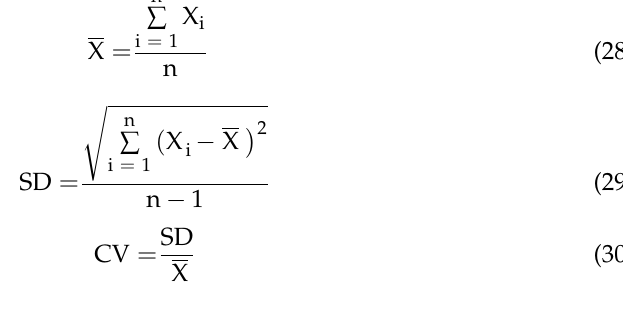
Table 5. Data analysis of test index.